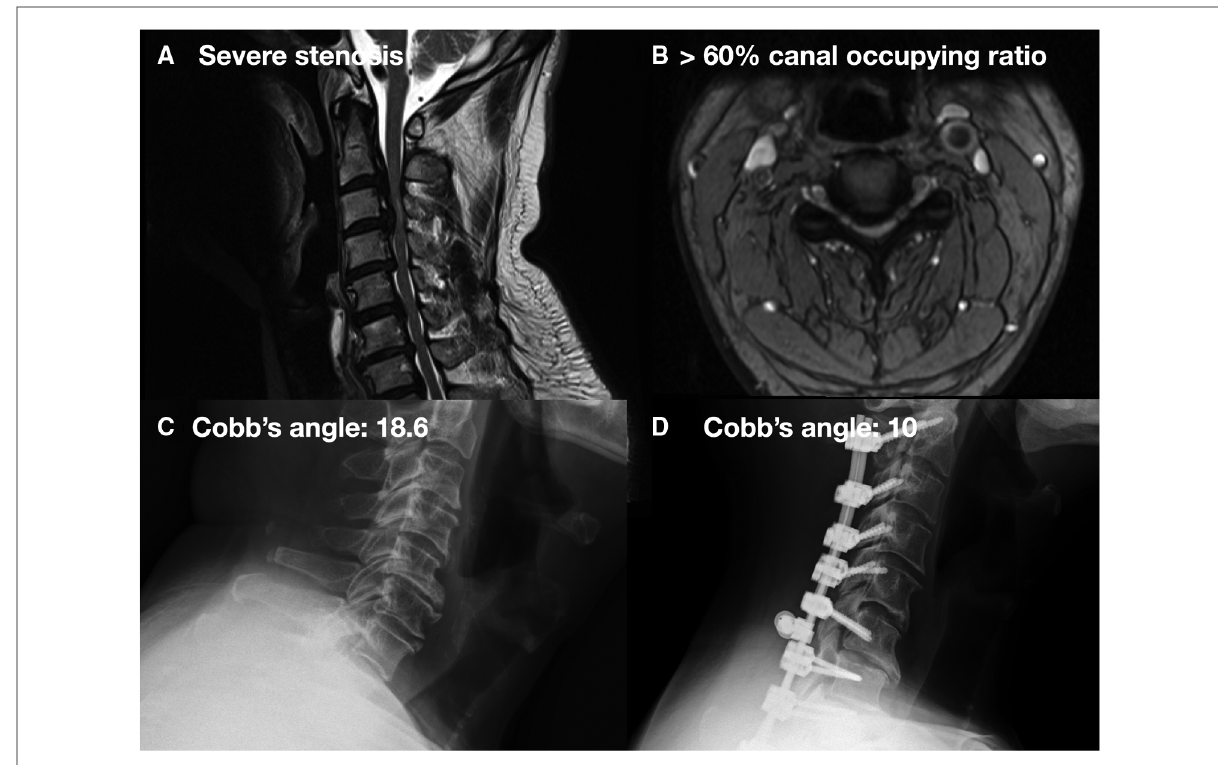
FIGURE 2 A 51-year-old male with CM due to long-segment massive OPLL over C2-7 underwent C2-7 laminectomy and C2 – T2 fi xation: ( A ) preoperative cervical MRI showed severe cervical stenosis with bulging disc. ( B ) Preoperative cervical MRI axial view showed >60% canal occupying ratio. ( C ) Preoperative cervical x-ray showed cervical lordosis about 18.6°. ( D ) Postoperative cervical x-ray showed cervical lordosis about 10°.